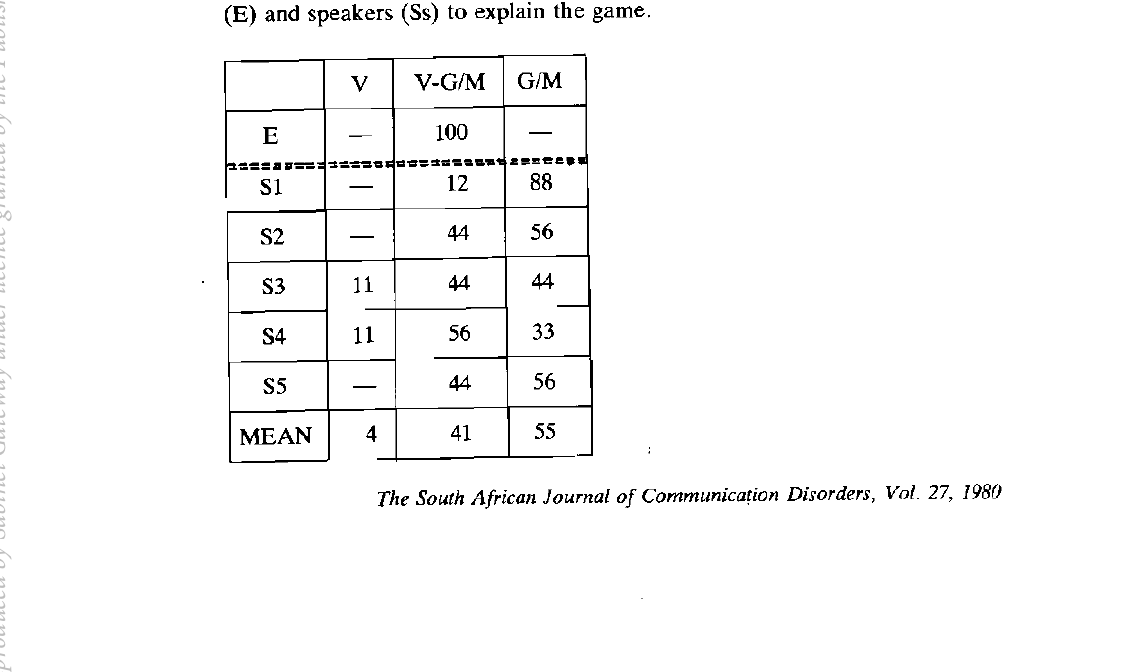
TABLE II: The percentage of game items explained through each of the three channels, including a comparison between channels used by the experimenter (E) and speakers (Ss) to explain the